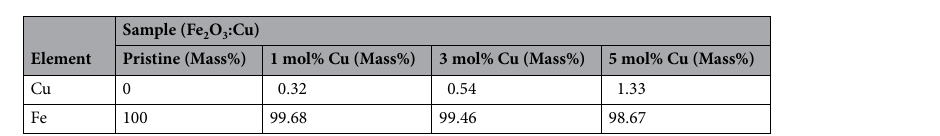
Sample (Fe 2 O 3 Element